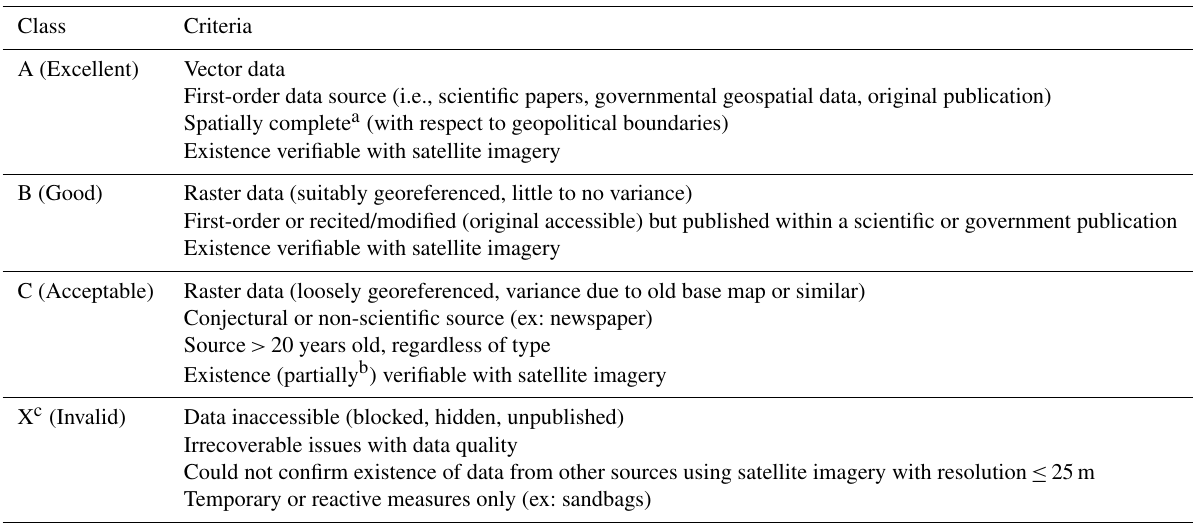
Table 3. Data quality definition for levees based on data provenance, both for use in initial data classification and ongoing maintenance. Criteria are exclusively applied: all categories must be met to meet a certain